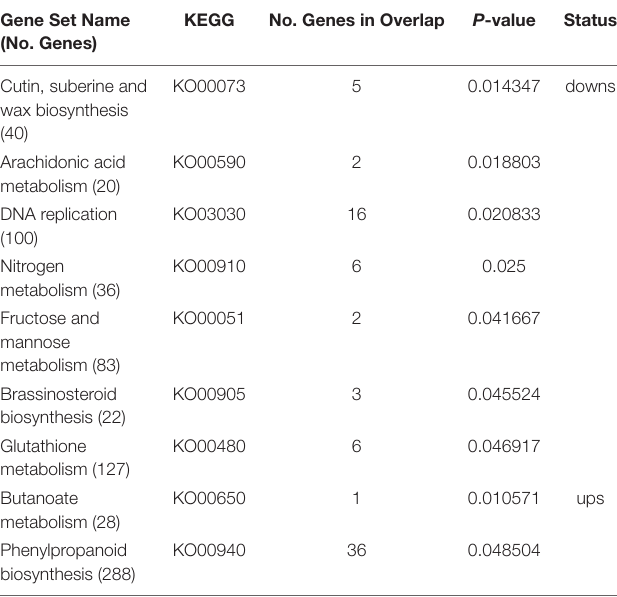
TABLE 2 | Enriched gene sets in genes up-regulated and down-regulated in WT during fruit set process by